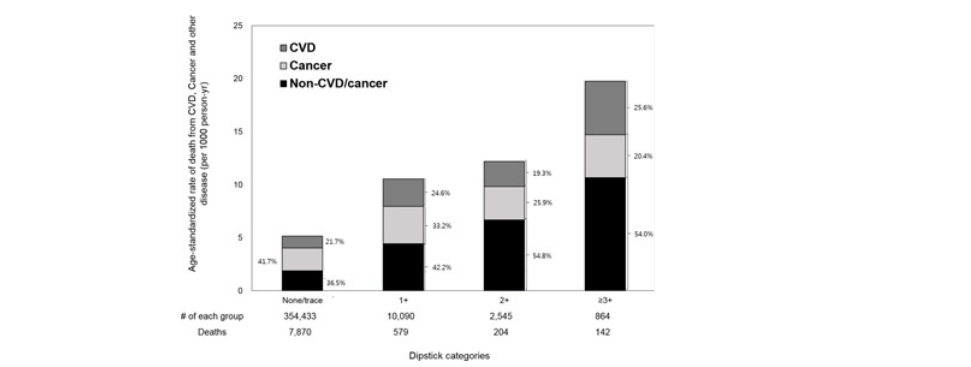
founders (Table 3). For all mortality outcomes, risk was significantly increased even in the 1+ proteinuria group. When we used data from the 13 centers (N = 178,603 and 6,448 deaths)